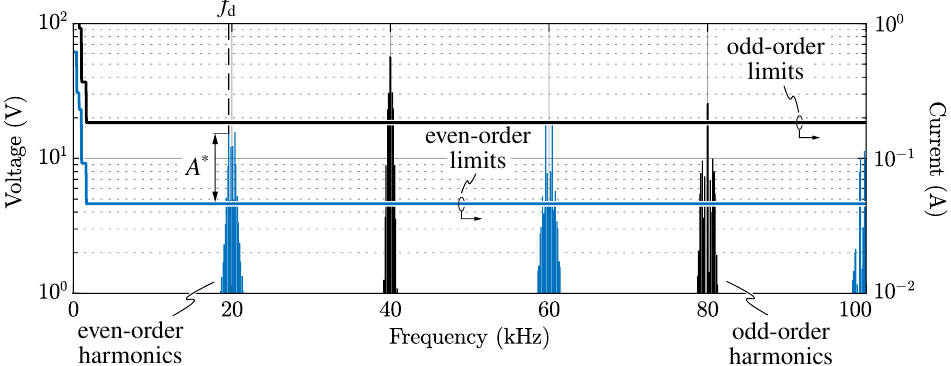
Figure 9. Converter output voltage harmonic spectrum at V dc = 800V and current harmonic limits according to IEEE 519. Odd and even-order harmonics are colored in black and blue respectively. The filter design frequency f d and the required attenuation A ∗ (without the margin) are